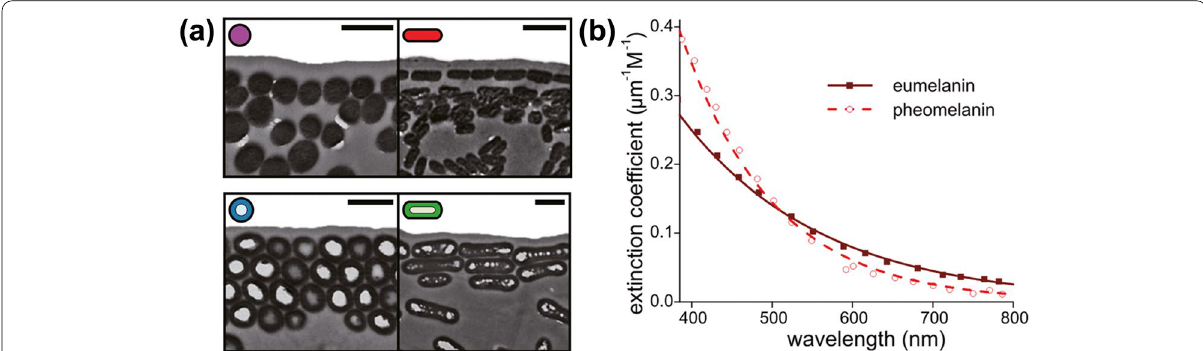
Fig. 3 Structural and optical properties of melanin. ( a ) Melanosomes in birds have four main structures: nanoparticles (purple), nanorods (red), hollow nanorods (blue), and hollow platelets (green). (Scale bars: 500 nm). Reproduced with permission (Maia et al. 2013). Copyright 2013,